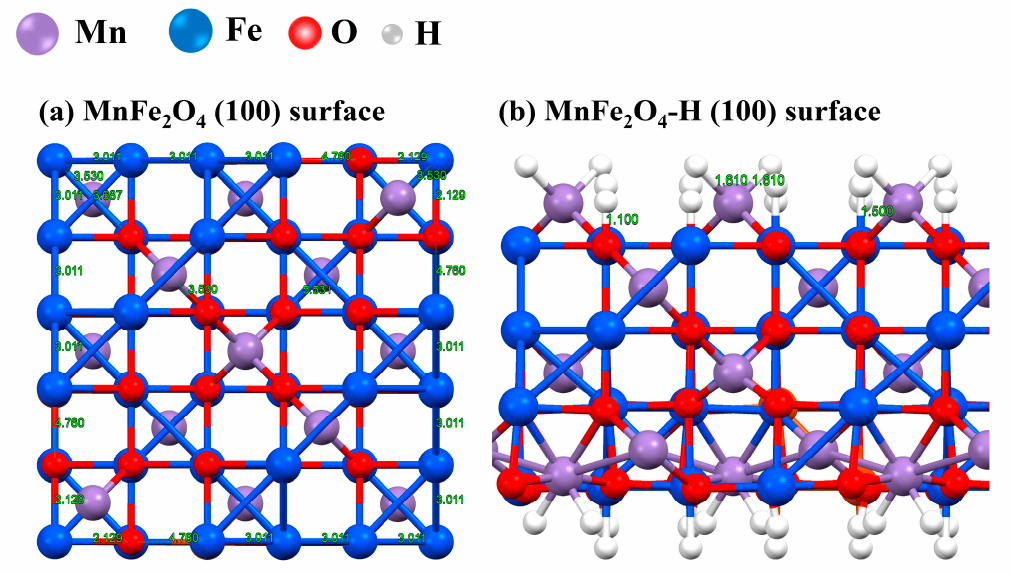
Figure 5. The optimum structure of ( a ) MnFe 2 O 4 (100) surface and ( b ) MnFe 2 O 4 − H (100) surface.